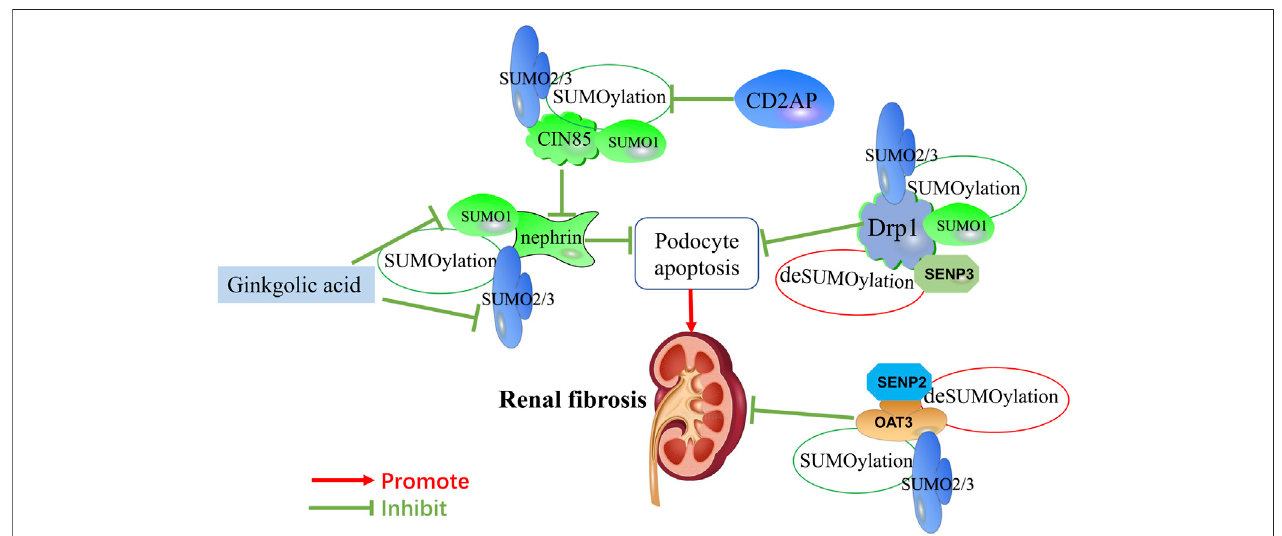
FIGURE2| MechanismsofSUMOylationanddeSUMOylationbykeymediatorsinrenal fi brosisandtherapeutictargetsofnaturalproductsagainstrenal fi brosisvia SUMOylation. Mechanisms of SUMOylation and deSUMOylation by key mediators in renal fi brosis are including podocyte apoptosis, and OAT3-mediated transfer channels. As one of component of the slit diaphragm, nephrin is SUMOylated by SUMO1 and SUMO2/3. CD2AP promotes the expression of nephrin by inhibiting the SUMOylation of CIN85. Drp1 is SUMOylated by SUMO1 and SUMO2/3. OAT3 is SUMOylated by SUMO2/3. SNEP3 deSUMOylates Drp1, and SNEP2 deSUMOylates OAT3. Ginkgolic acid inhibits the expression of nephrin by downregulating SUMO1 and SUMO2/3.